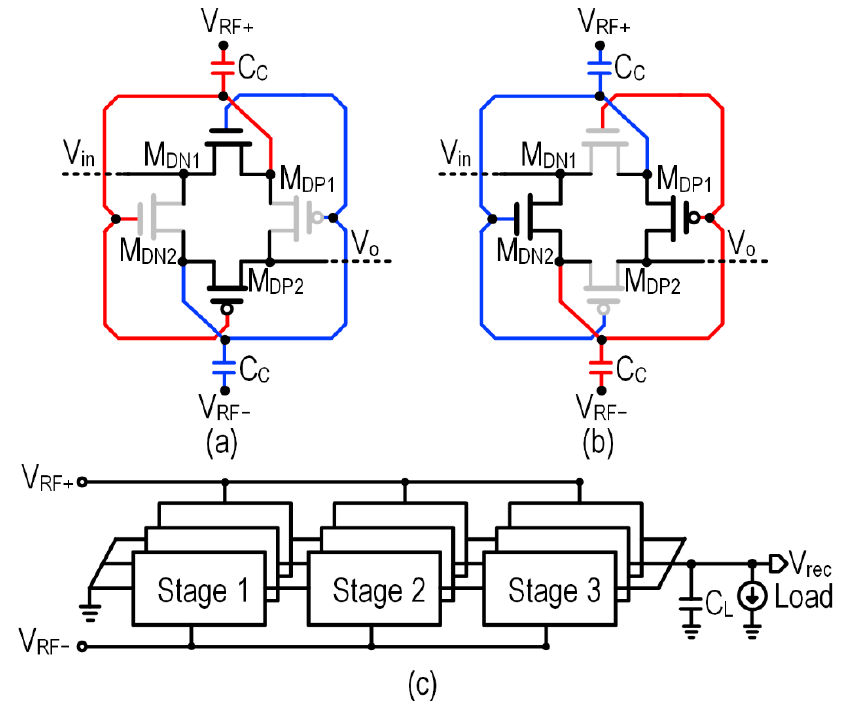
Figure 3. RFEH front-end: ( a , b ) Operation of differential cross-coupled (DCC) rectifier and ( c ) Pro- posed 3 × 3 rectifier.